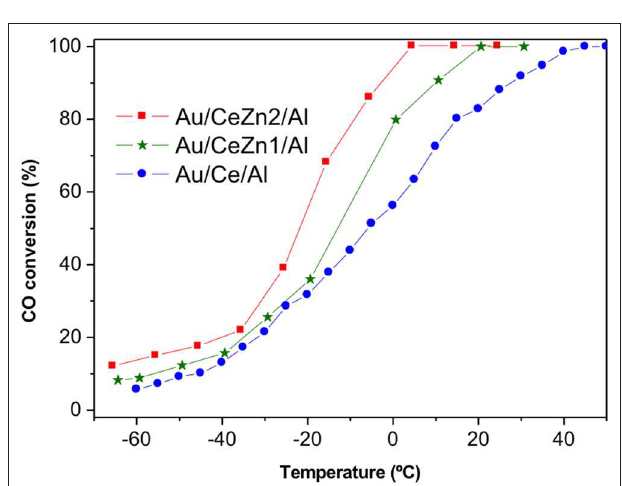
FIGURE 6 | Sub-ambient CO oxidation